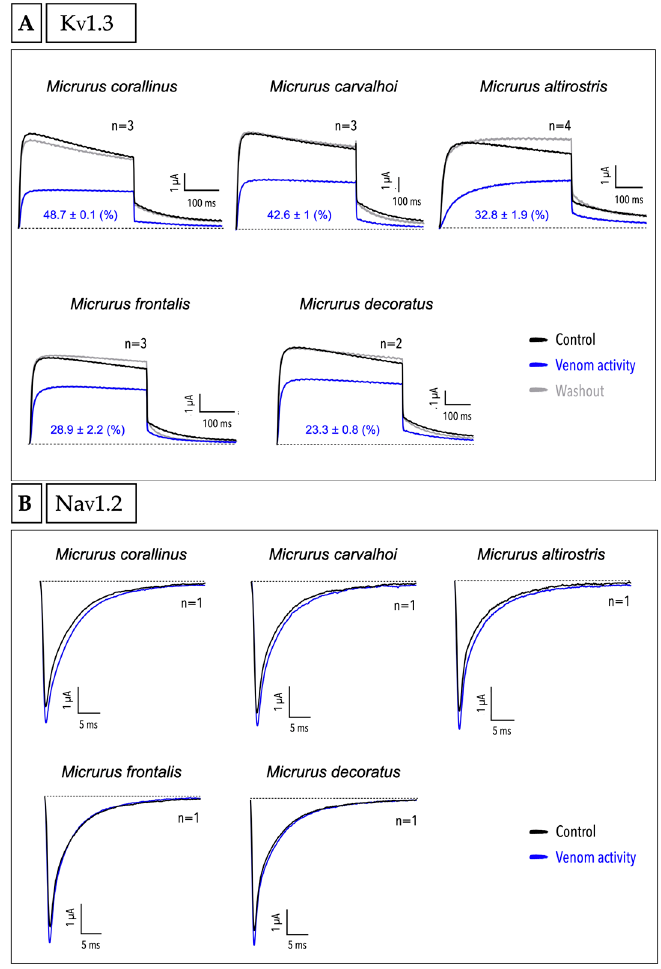
Figure 6. Screening of crude venoms from different Micrurus species in different voltage-gated ion channels. ( A ) K V 1.3. The inhibition percentage and the SEM are shown in blue for each graph. ( B ) Na V 1.2. The black lines represent the control and the blue lines represent the channel response after incubation with 10 µg of crude venom. The dotted lines represent the zero current level. The n from each experiment is shown as well as the current/time reference bar. The graphs show the trace of one experiment from a series of independent experiments, with the exception of tests with n = 1.